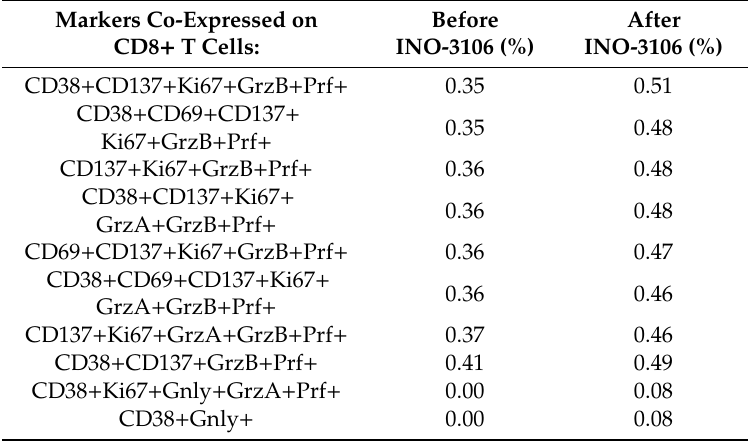
Table 2. CD8 + T Cell Phenotyping for Patient